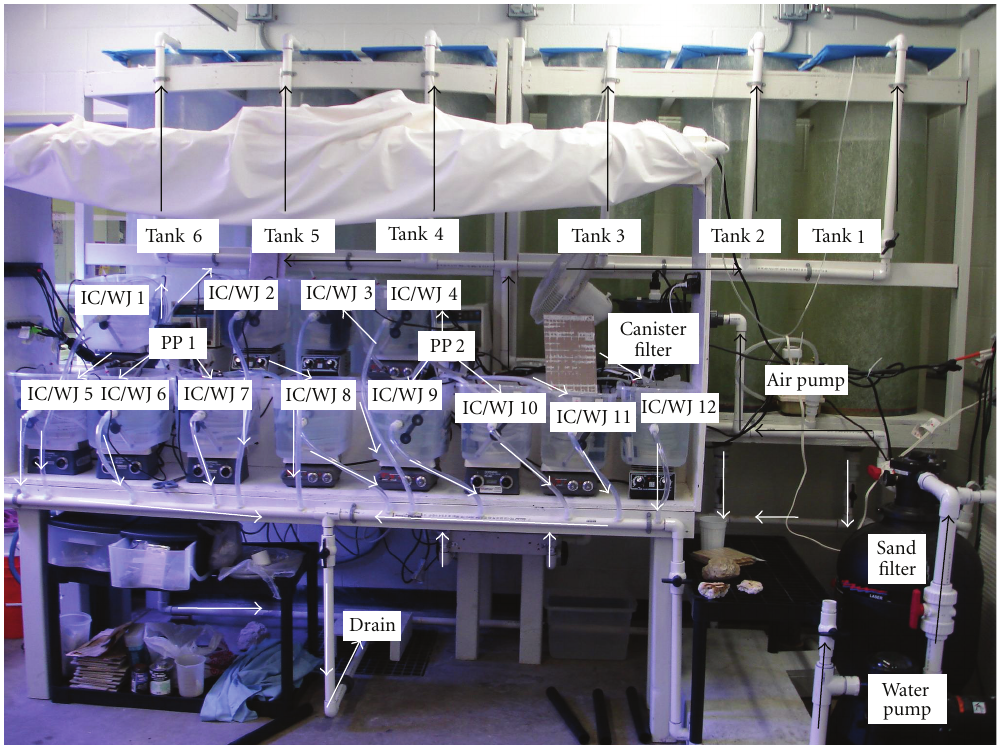
Figure 1: Flow-through seawater system consisting of sand and UV light filtration. Water was pumped into five of the six storage tanks through the filter system by a 1.5hp centrifugal Jacuzzi pump (pump and filter system used only prior to experimentation to prevent pump cavitation). Incoming water enters the pump, passes through the sand filter and a 5 µ m Canister filter coupled with UV-light sanitization, and is then passed to the storage tanks. During experimental trials, water is pumped to the twelve incubation chambers (IC), exiting via a drain.